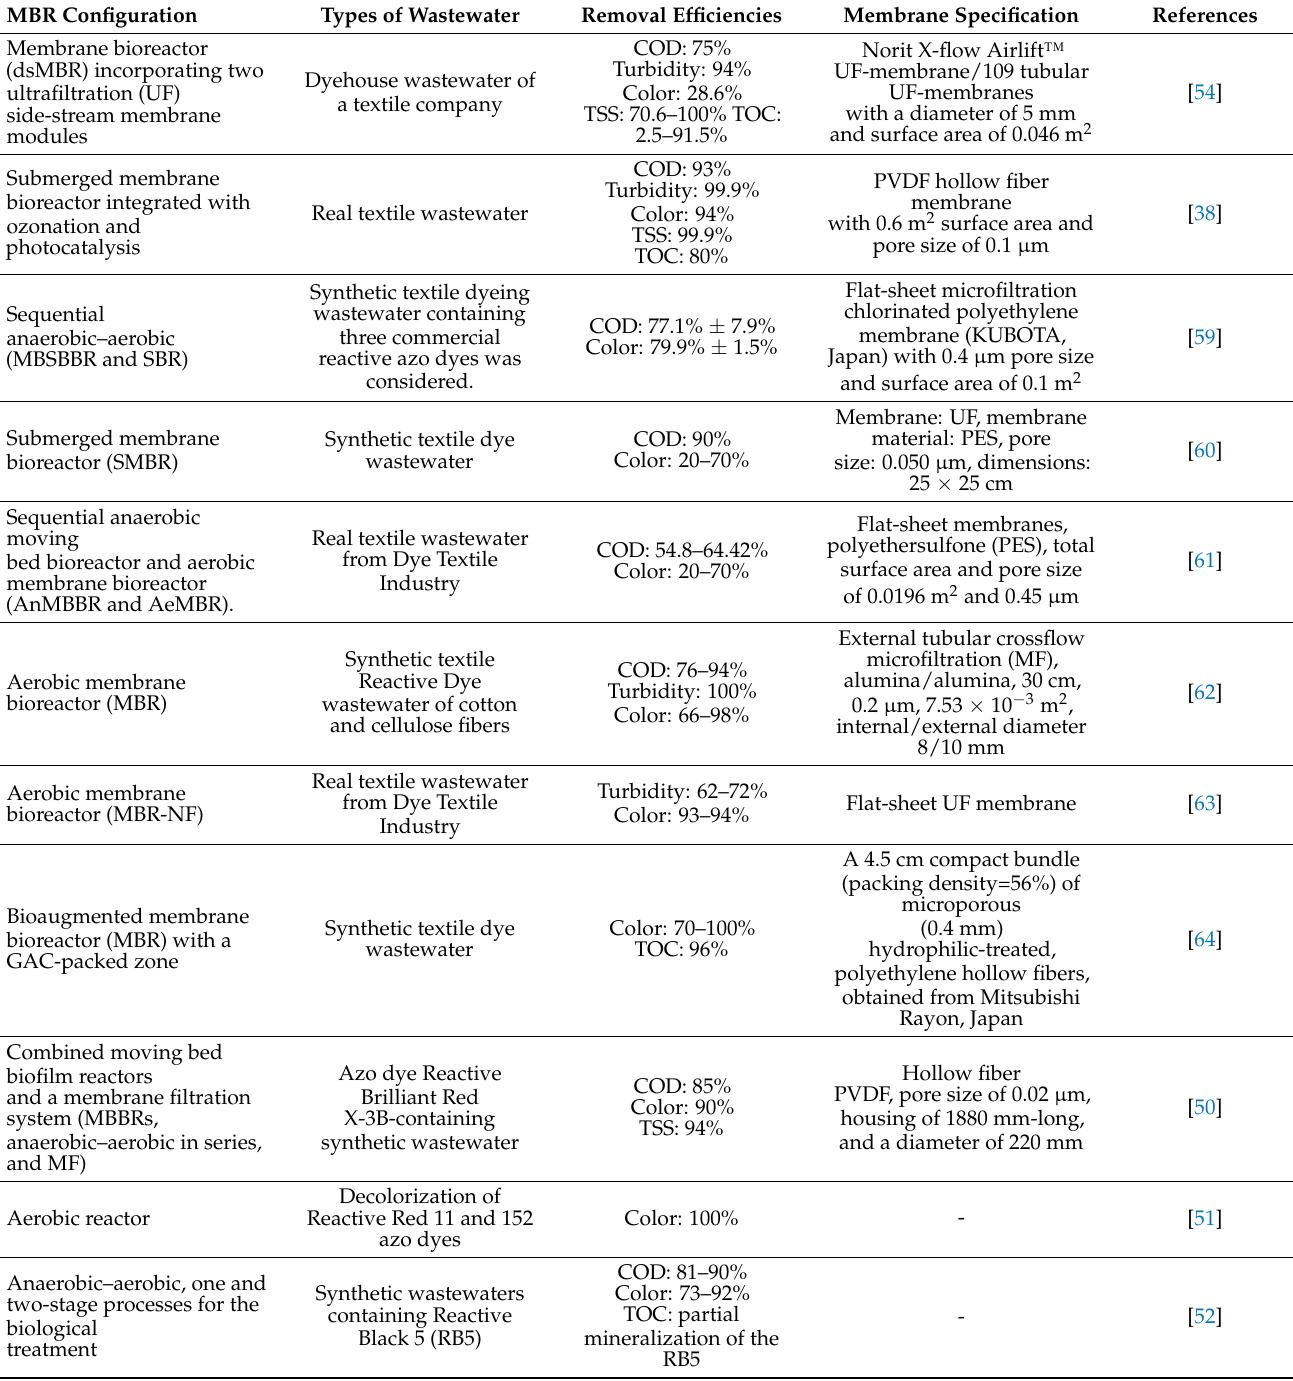
Table 6. Results obtained from previous